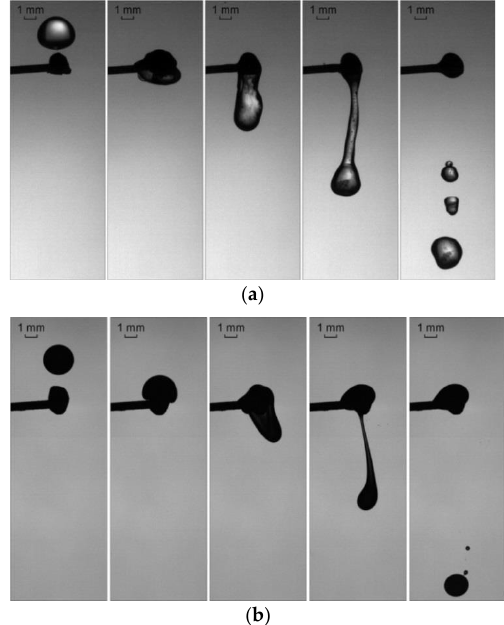
Figure 3. Images of the interaction of liquid droplets with carbonaceous particles of coking coal filter cake at Δ = 0.5: ( a ) — water; ( b ) — used motor oil.